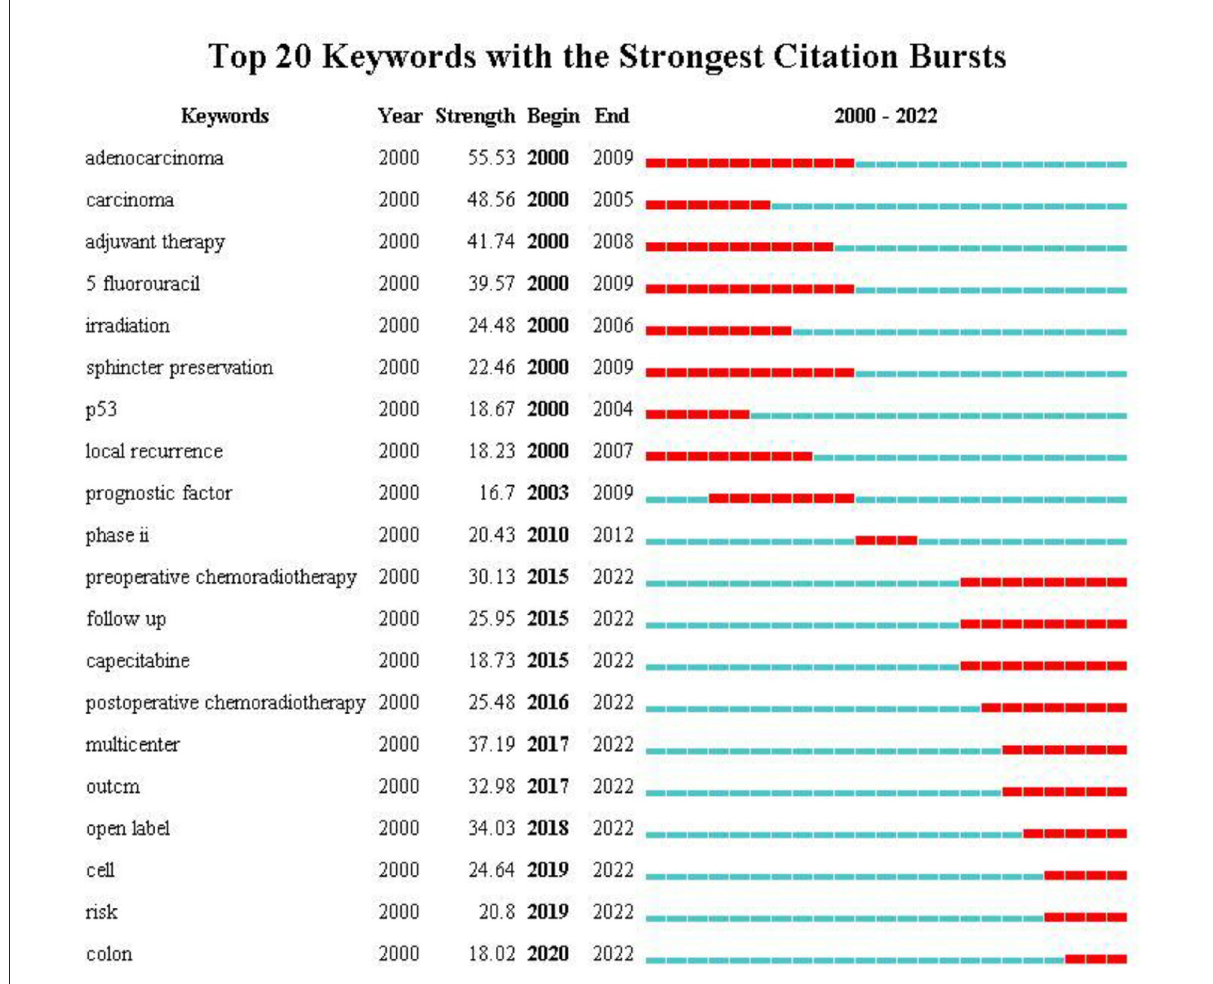
FIGURE8 Top 15 keywords related to radiation therapy for rectal cancer with burst period after